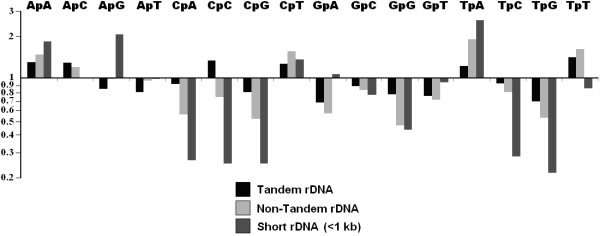
Fold changes in di-nucleotide abundances between Stagonospora nodorum rDNA repeat sub-categories. Tandem (black), non-tandem (light-grey) and short < 1 kb (dark grey) on a Log10 scale. Tandem rDNA repeats exhibit lesser variations in TpA, CpA and TpG counts, therefore are less RIP-affected than non-tandem and short < 1 kb rDNA repeats.